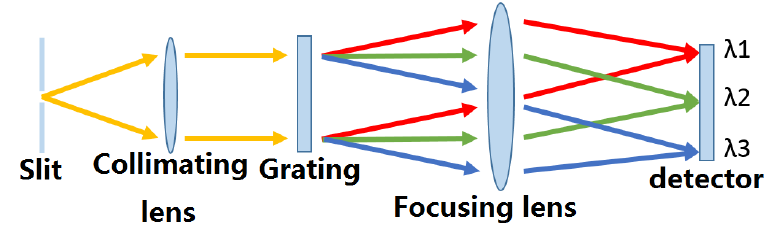
Figure 1. Principle of imaging